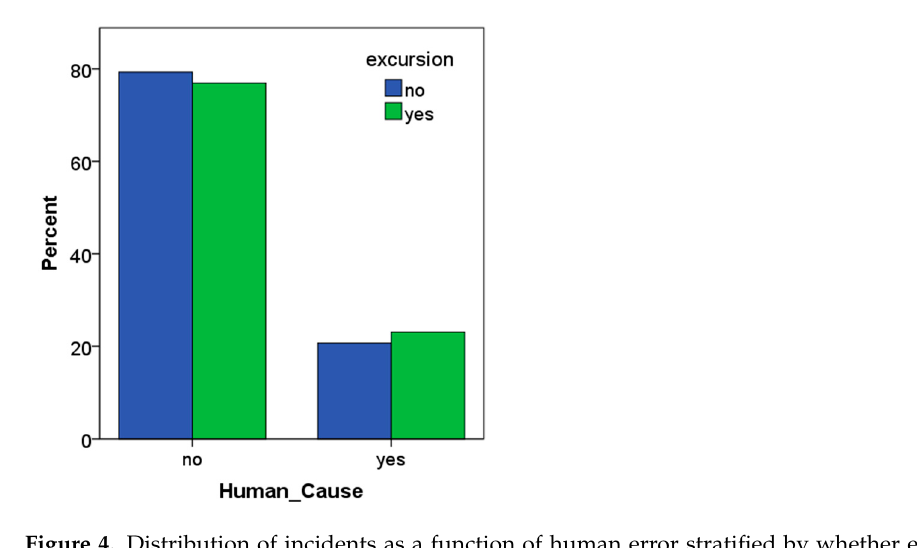
Figure 4. Distribution of incidents as a function of human error stratified by whether excursion occurred.